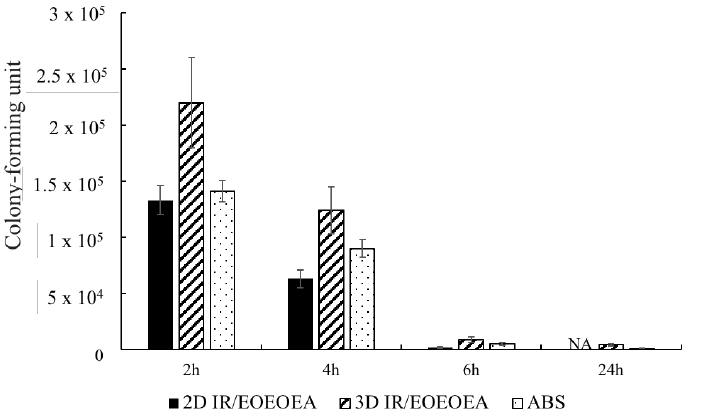
Figure 8. The anti-bacterial effect of 2D and 3D model in different time under a shaking of 50 rpm in the pH 2 environment. Two-dimensional IR/EOEOEA is a photo-cured flat surface sample. Three- dimensional IR/EOEOEA is a photo-cured sample with gastric rugae. ABS is a flat surface sample.